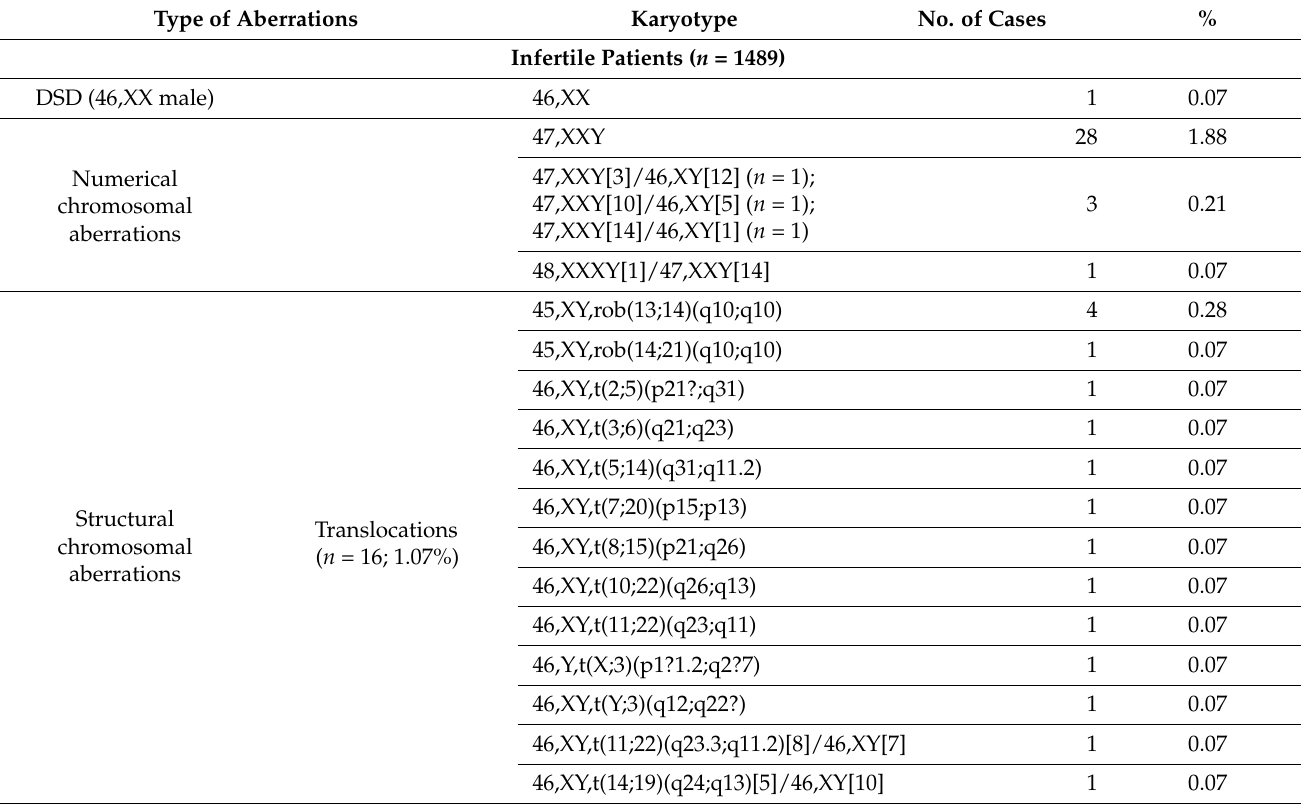
Table 1. Chromosomal abnormalities in infertile male patients and control group.